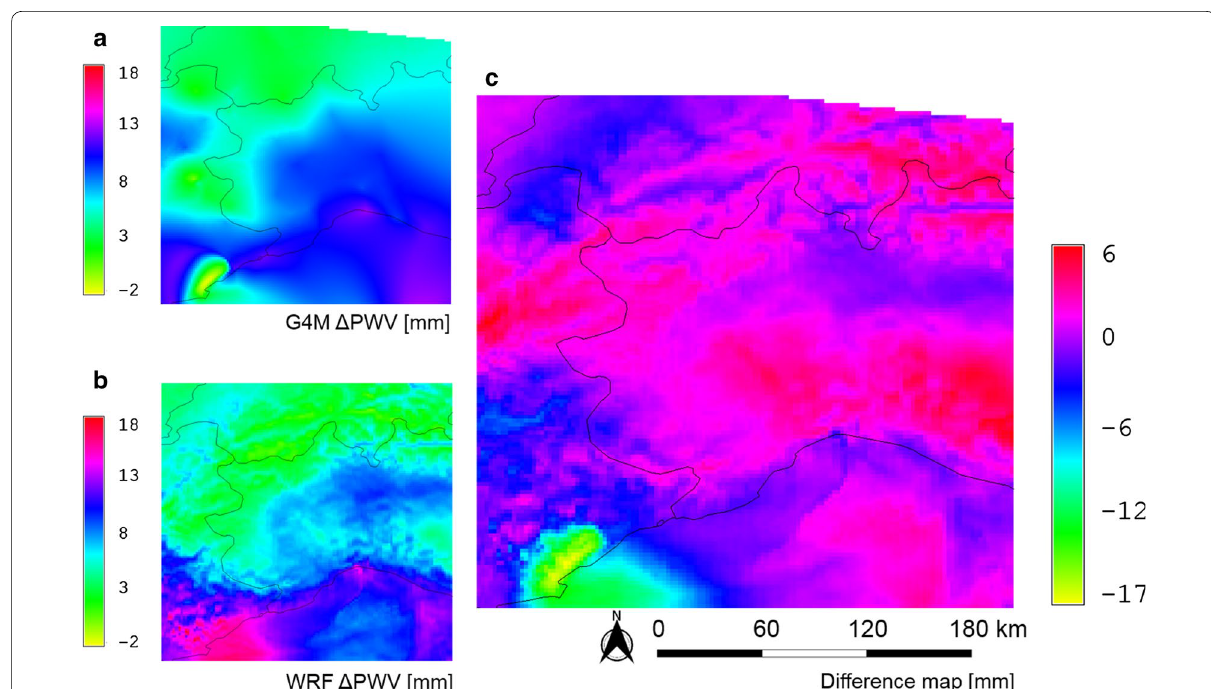
Fig. 7 ∆PWV map based on the G4M procedure ( a ) and WRF ( b ). c Depicts the ∆PWV difference map (G4M-WRF). The maps refer to November 4, 2011, 10:00 UTC with respect to November 3, 2011, 02:00